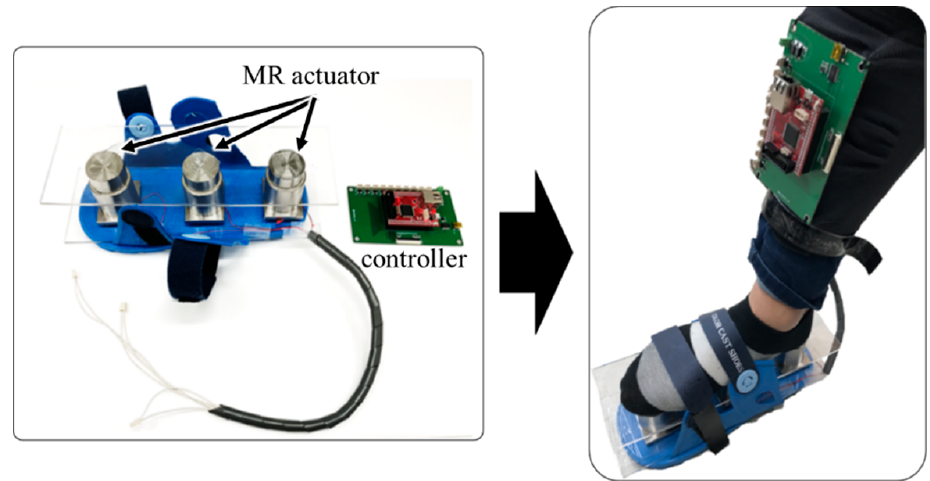
Figure 14. Three MR haptic actuators which are installed to the shoe.